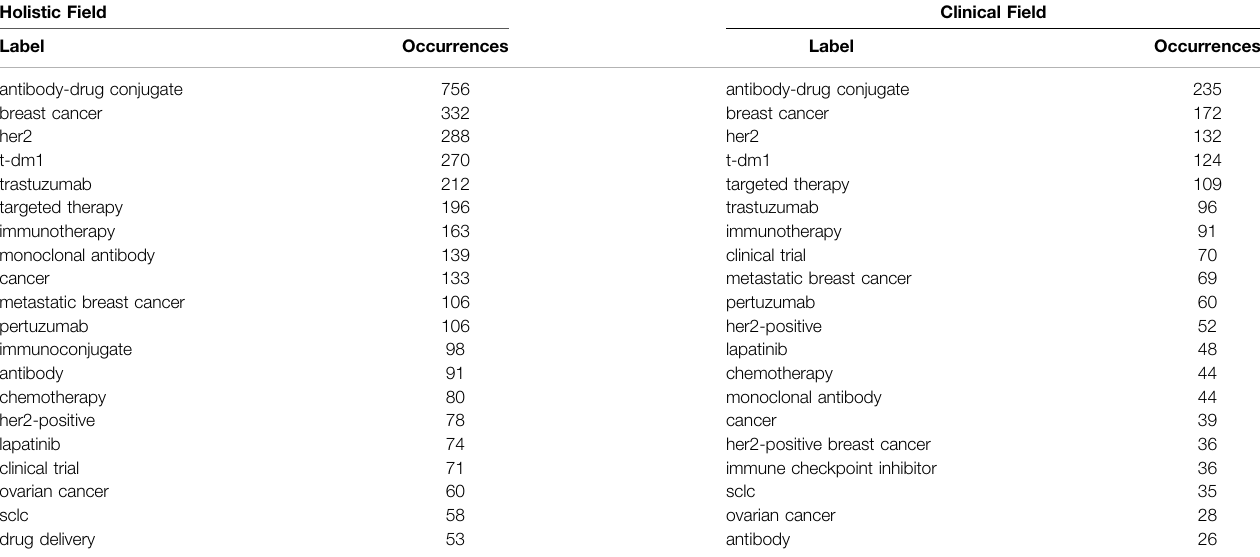
TABLE 5 | The top 20 keywords in terms of the occurrence of ADC research in the solid cancer fi eld. Holistic